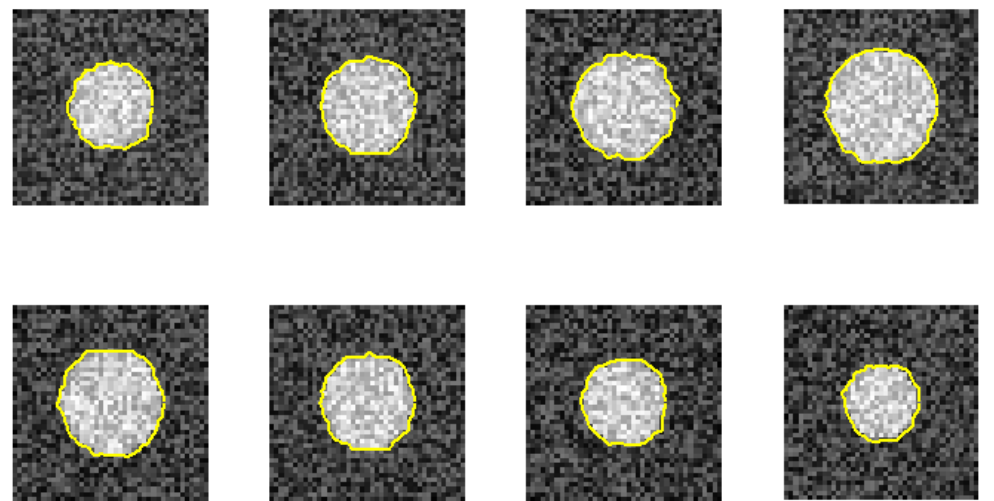
Figure 6. The contour detection results. SNR = 14 dB, s = 0.01, resize factor = 1.6. Averaged unsigned error =